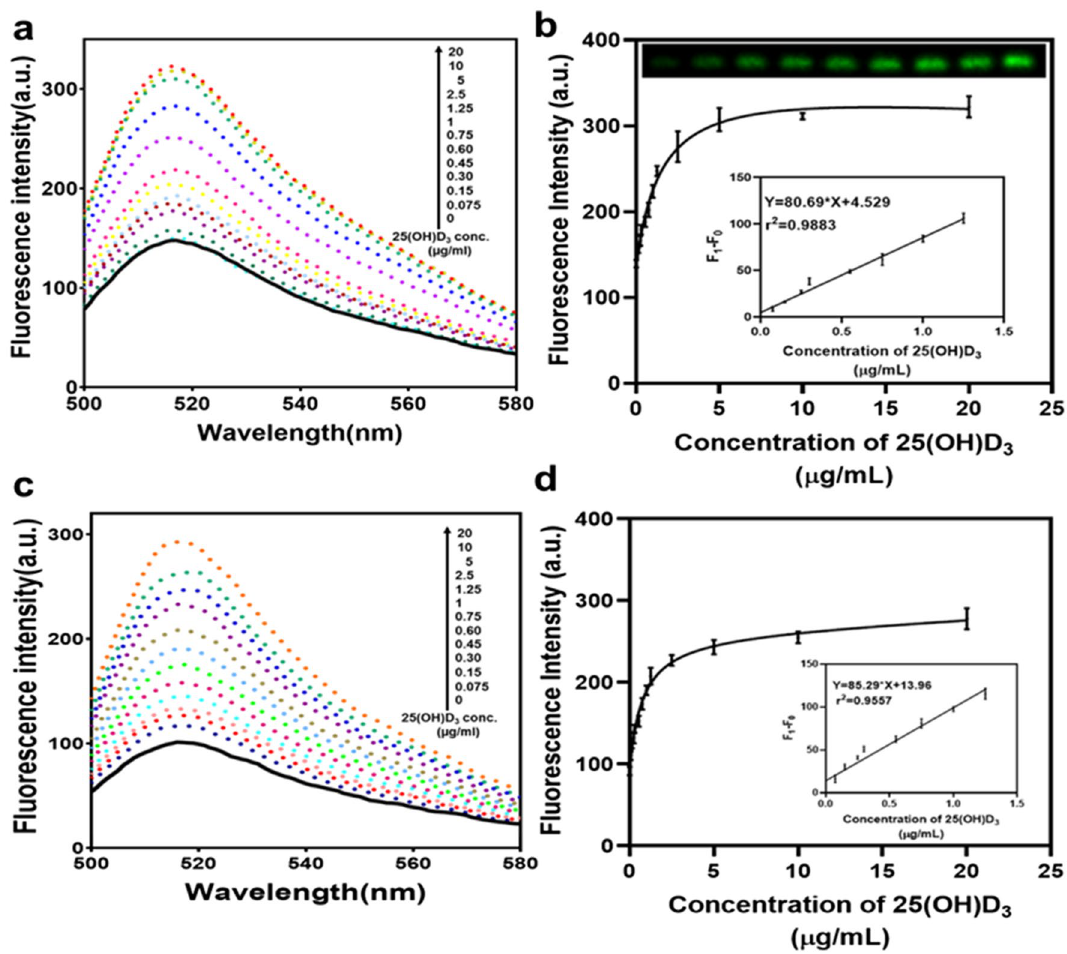
Figure 4. Assessment of fluorescence intensity obtained with 25(OH)D 3 . ( a , b ) Fluorescent spectra and fluorescent intensity of the aptamer with different conc. of 25(OH)D 3 and 3% agarose gel image confirming the increase in fluorescence in presence of 25(OH)D 3 using GO. Inset: Peak fluorescence change shows a linear relationship with 25(OH)D 3 concentration (0–1.25 µg/mL). ( c , d ) Fluorescent spectra and fluorescent intensity of the aptamer with different conc. of 25(OH)D 3 using GO-COOH. Inset: Peak fluorescence change shows a linear relationship with 25(OH)D 3 concentration (0–1.25 µg/mL). (Apt –100 nM, GO and GO-COOH-50 µg/ mL) F0: Aptamer + GO ( b ) and Aptamer + GO-COOH ( d ); and F1: Apt + GO + 25(OH)D 3 ( b ) and Apt + GO-COOH + 25(OH)D 3 ( d